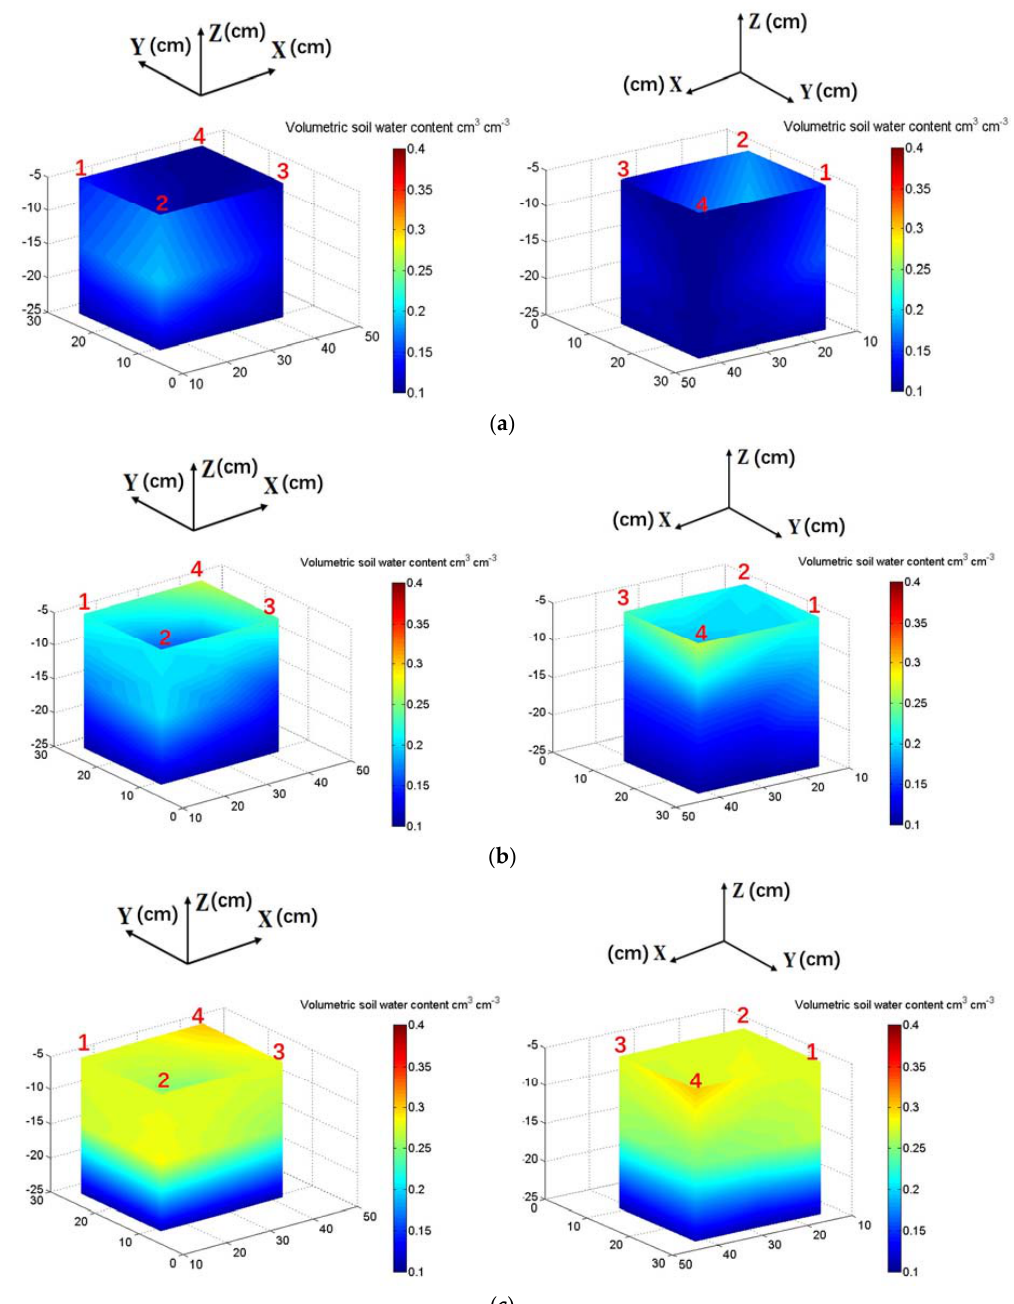
Layer-1 ( − 5, − 10 and − 15 cm) shows a higher initial VSWC at Zone-1 with a lighter blue color. At the time of 1:30 (Figure 8b), due to the fast infiltration at Zone-3 and Zone-4, the color at − 5 cm turned to green, with the VSWC values higher in comparison with those at Zone-1 and Zone-2. At the time of 3:00 (Figure 8c), the VSWCs were saturated at − 5 cm and the wet front penetrated deeper to the − 15 cm. At the time of 4:30 (Figure 8d), the VSWCs at − 5, − 10 and − 15 cm were saturated and the wet front had already arrived at the − 20 cm. At the time of 6:00 (Figure 8e), the wet front penetrated over the depth of 25 cm and the soil in the tank were almost saturated.